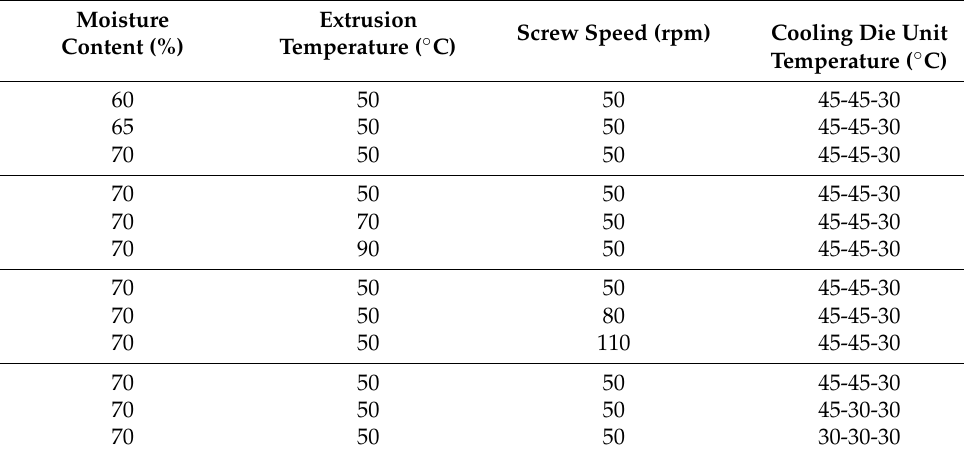
Figure 1. Schematic drawing of ( a ) the twin-screw extruder comprising a screw section (feeding section, mixing section, and heating section), connection modules, and a forming section; ( b ) the forming section composed of cooling die units. Table 1. Extrusion parameters during calcium caseinate extrusion